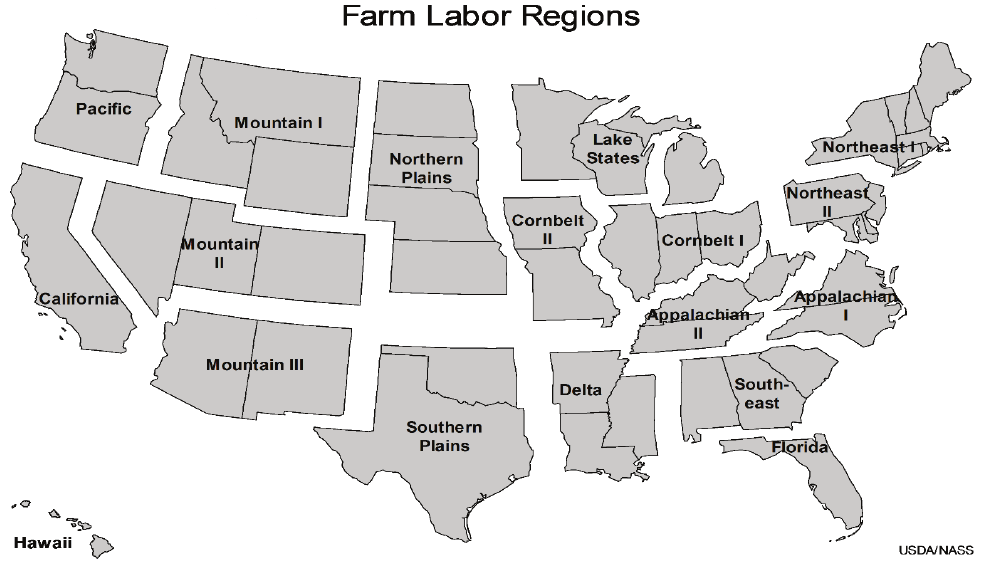
Figure 1. The 18 farm labor regions. Three states (California, Florida, and Hawaii) publish as their own